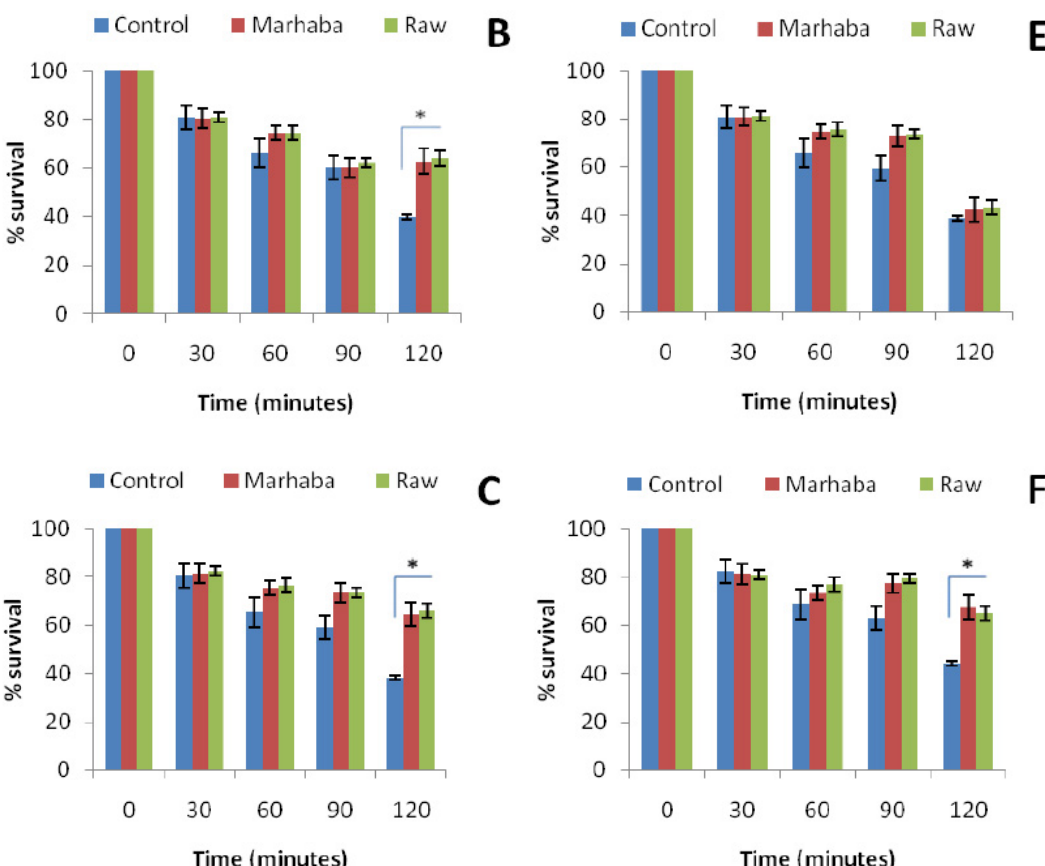
Figure 2. Effect of pH (2.5) in E. coli ATCC 10536 ( A , D ); S. Typhi ( B , E ) and K. pneumoniae ( C , F ) survival after the fourth passage of adaptation at ¼ × MIC ( A – C ) and the eighth until ½ × MIC ( D – F ) of branded and unbranded honey. ( p > 0.05); * ( p < 0.05).